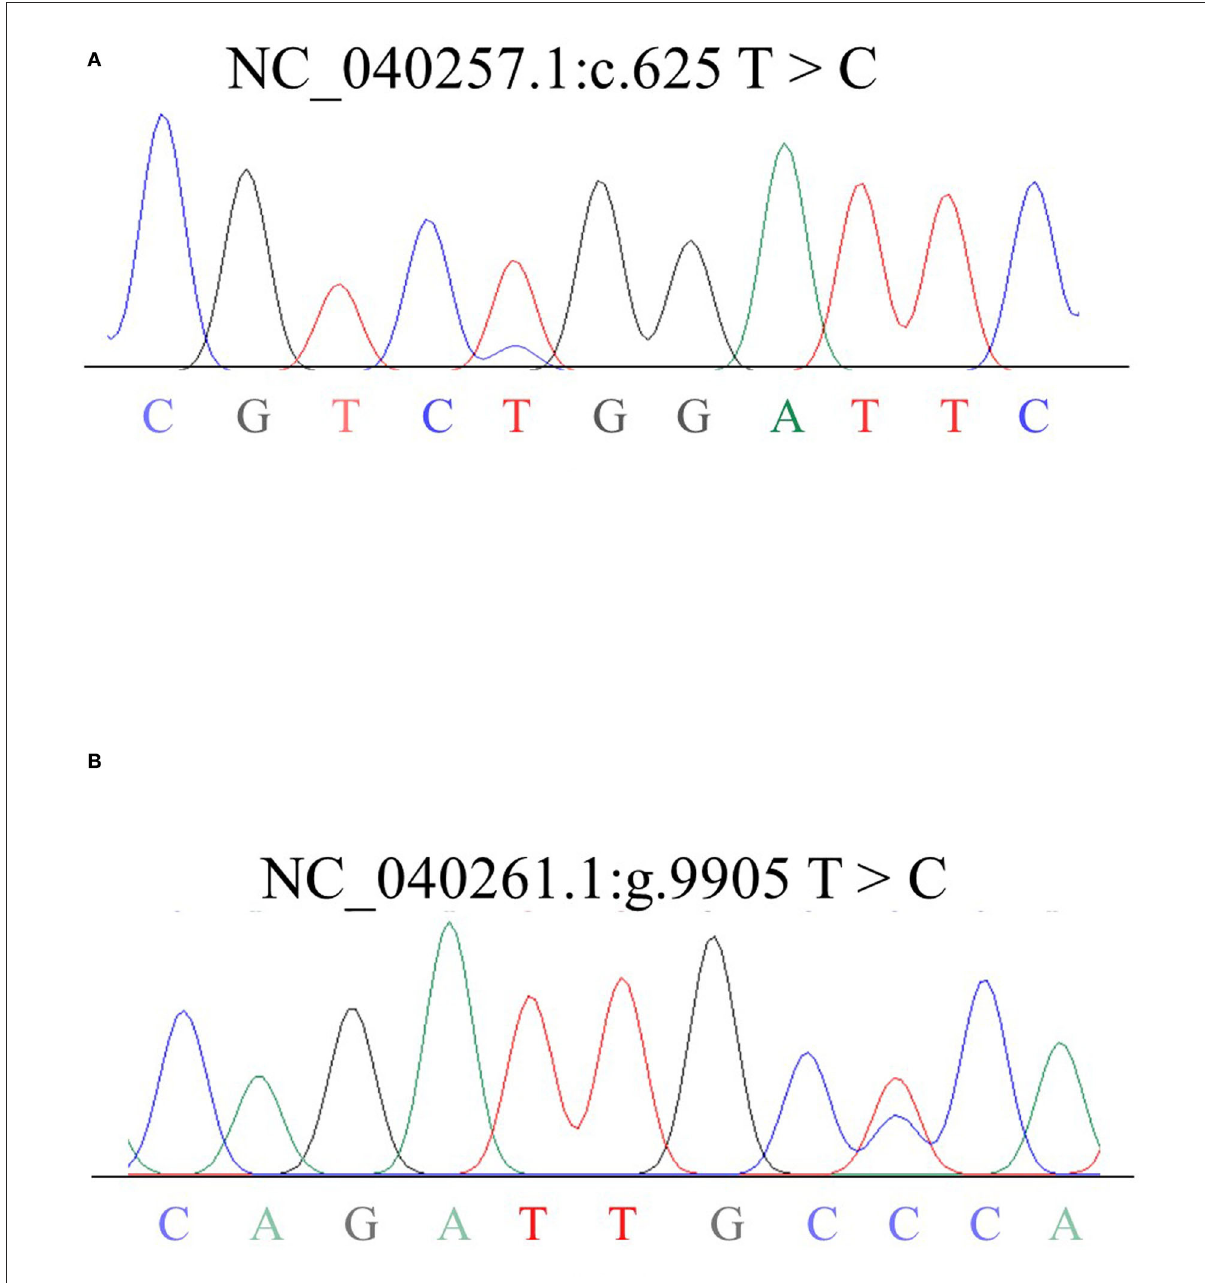
FIGURE2 Sequencing results of mixed DNA from Hu sheep SHISA3 (A) and RFC3 (B) . Overlapping peaks reflect mutation